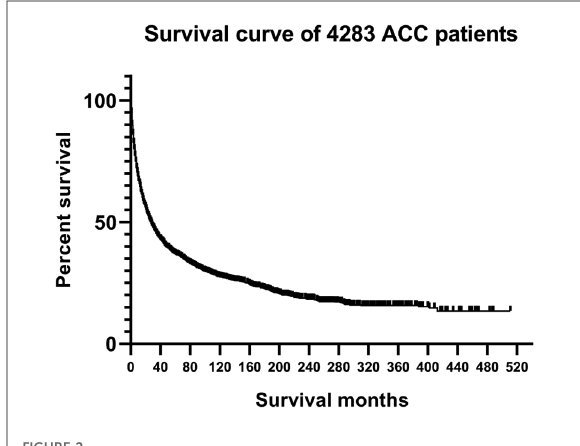
FIGURE 2 Overall survival curve of 4,283 patients with ACC.